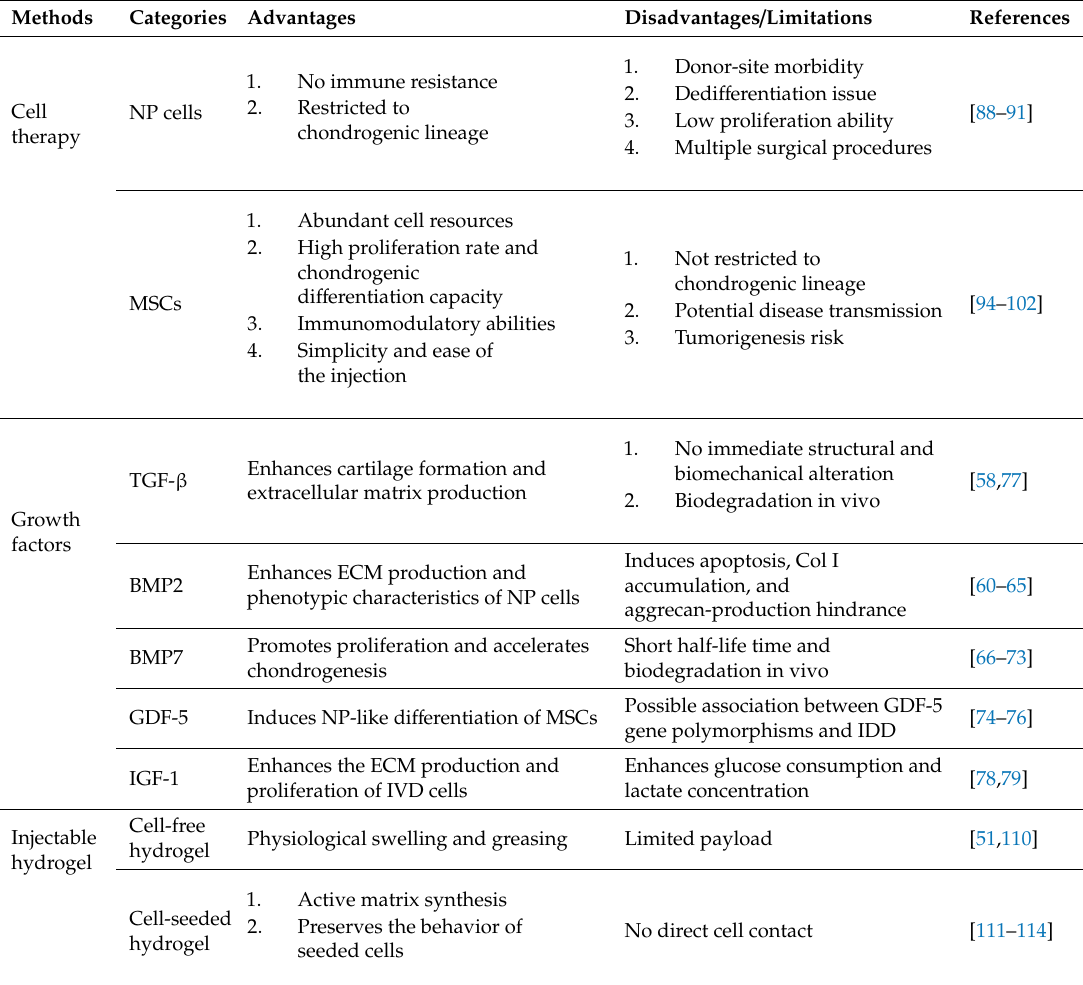
Table 1. Advantages and disadvantages of sca ff old-free IVD tissue